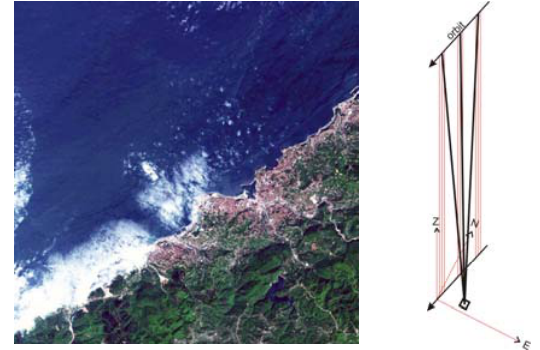
Figure 1. investigated area Zonguldak shown by Pleiades-1A image